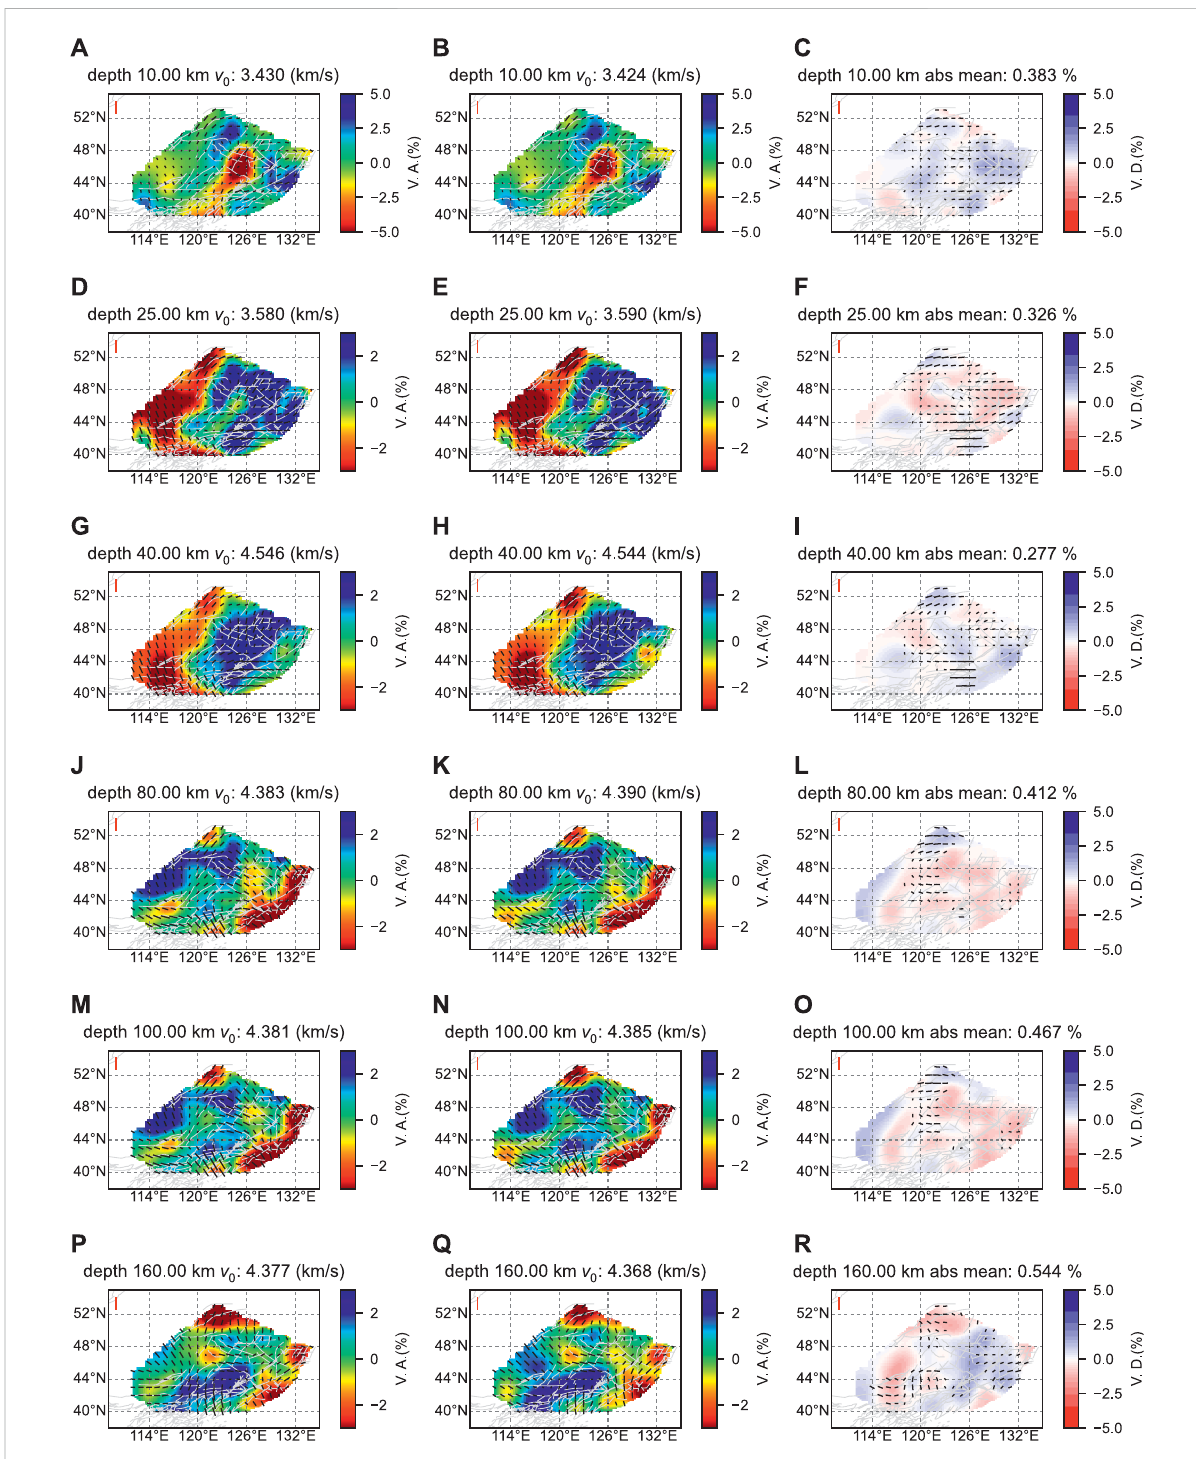
FIGURE 12 Azimuthally anisotropic S-wave velocities for Northeast China obtained from Rayleigh-wave tomography using dispersion curves derived by Surf-Net (left column) and manual (middle column) methods. The right column shows the difference between the two models. Shown here are horizontalslicesofthemodelsatdepthsof10 km (A – C) ,25 km (D – F) ,40 km (G – I) ,80 km (J – L) ,100 km (M – O) ,and160 km (P – R) .Ineachsubplot, the color represents the relative perturbation of the isotropic S-wave velocity from an average value given at the top, and the short line segments show anisotropy, with length and direction indicating strength and symmetry axes, respectively. The vertical red line in the top left corner of the map shows an anisotropy amplitude of 3%. The light grey lines show the